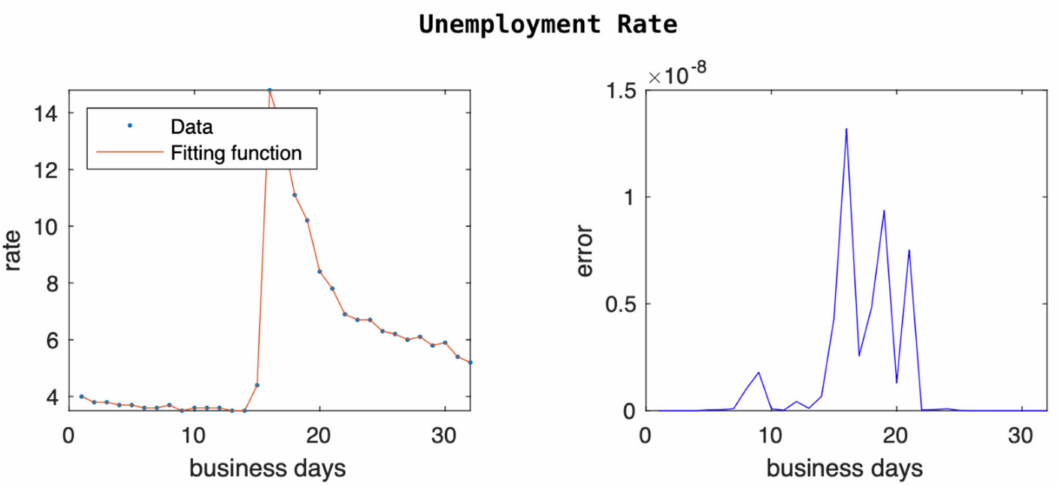
Figure 5. Fitting unemployment rate. Fitting function of unemployment rate since 1 January 2019 to 1 August 2019. N = 80, error range is [0, 1.32 × 10 − 8